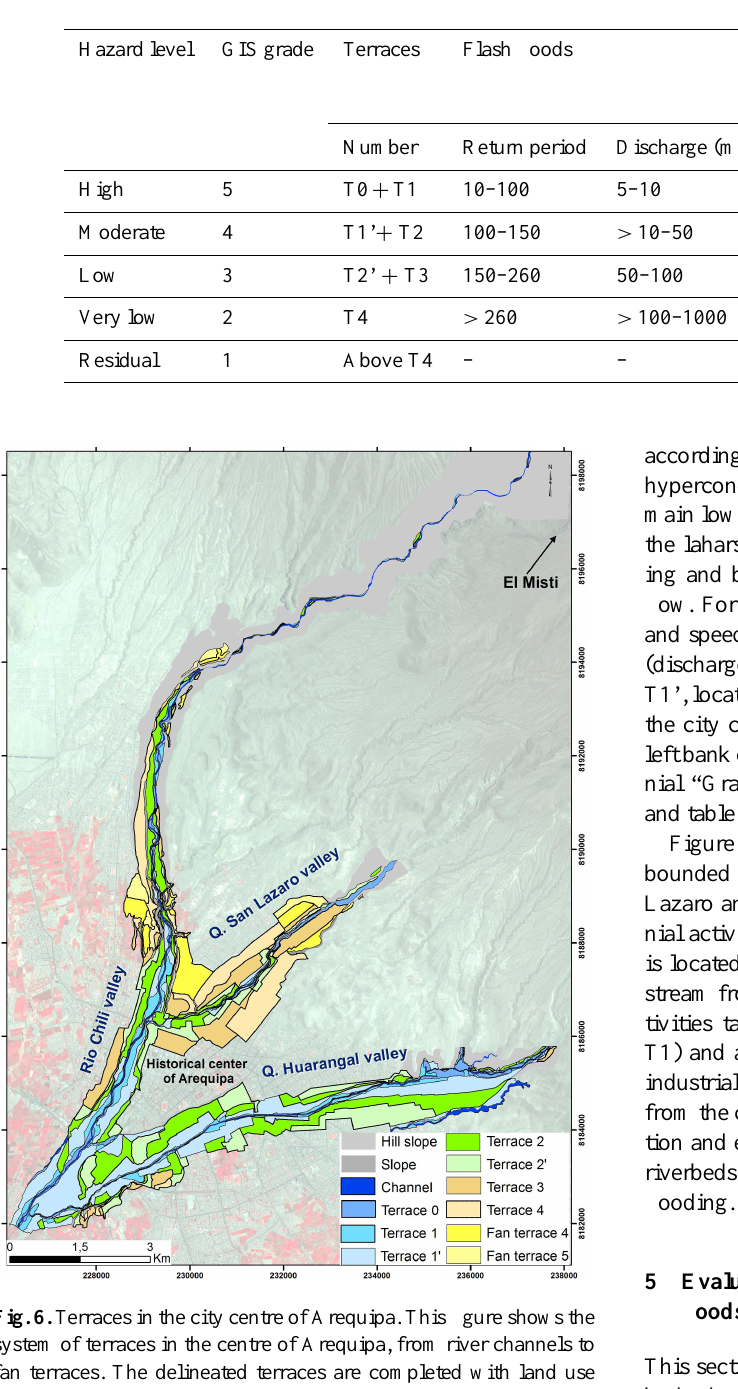
Table 3. Measuring hazard parameters at the city-block scale. Hazard levels resulting from the delineation of terraces (height above channel and return period) are represented in Fig. 5.